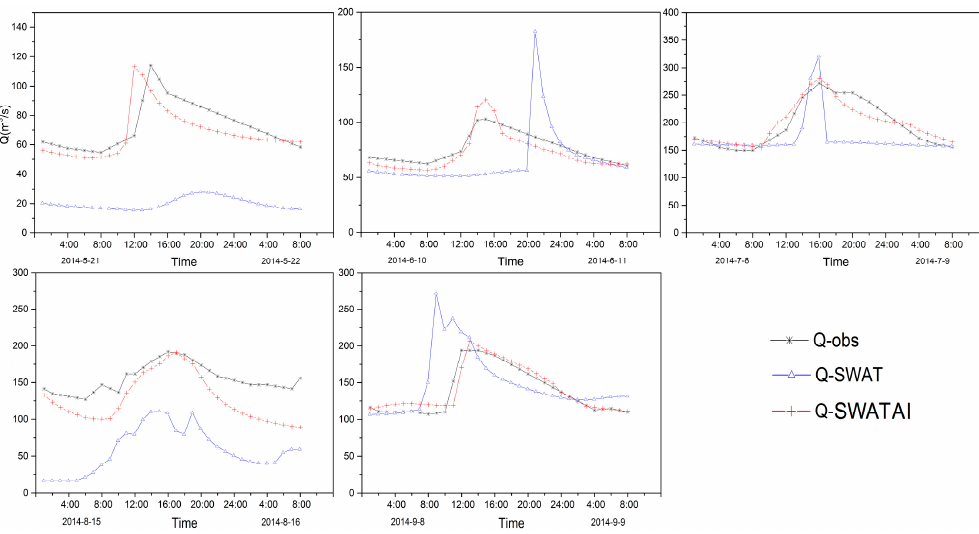
Figure 4. Hourly simulation results during the calibration period (2013).